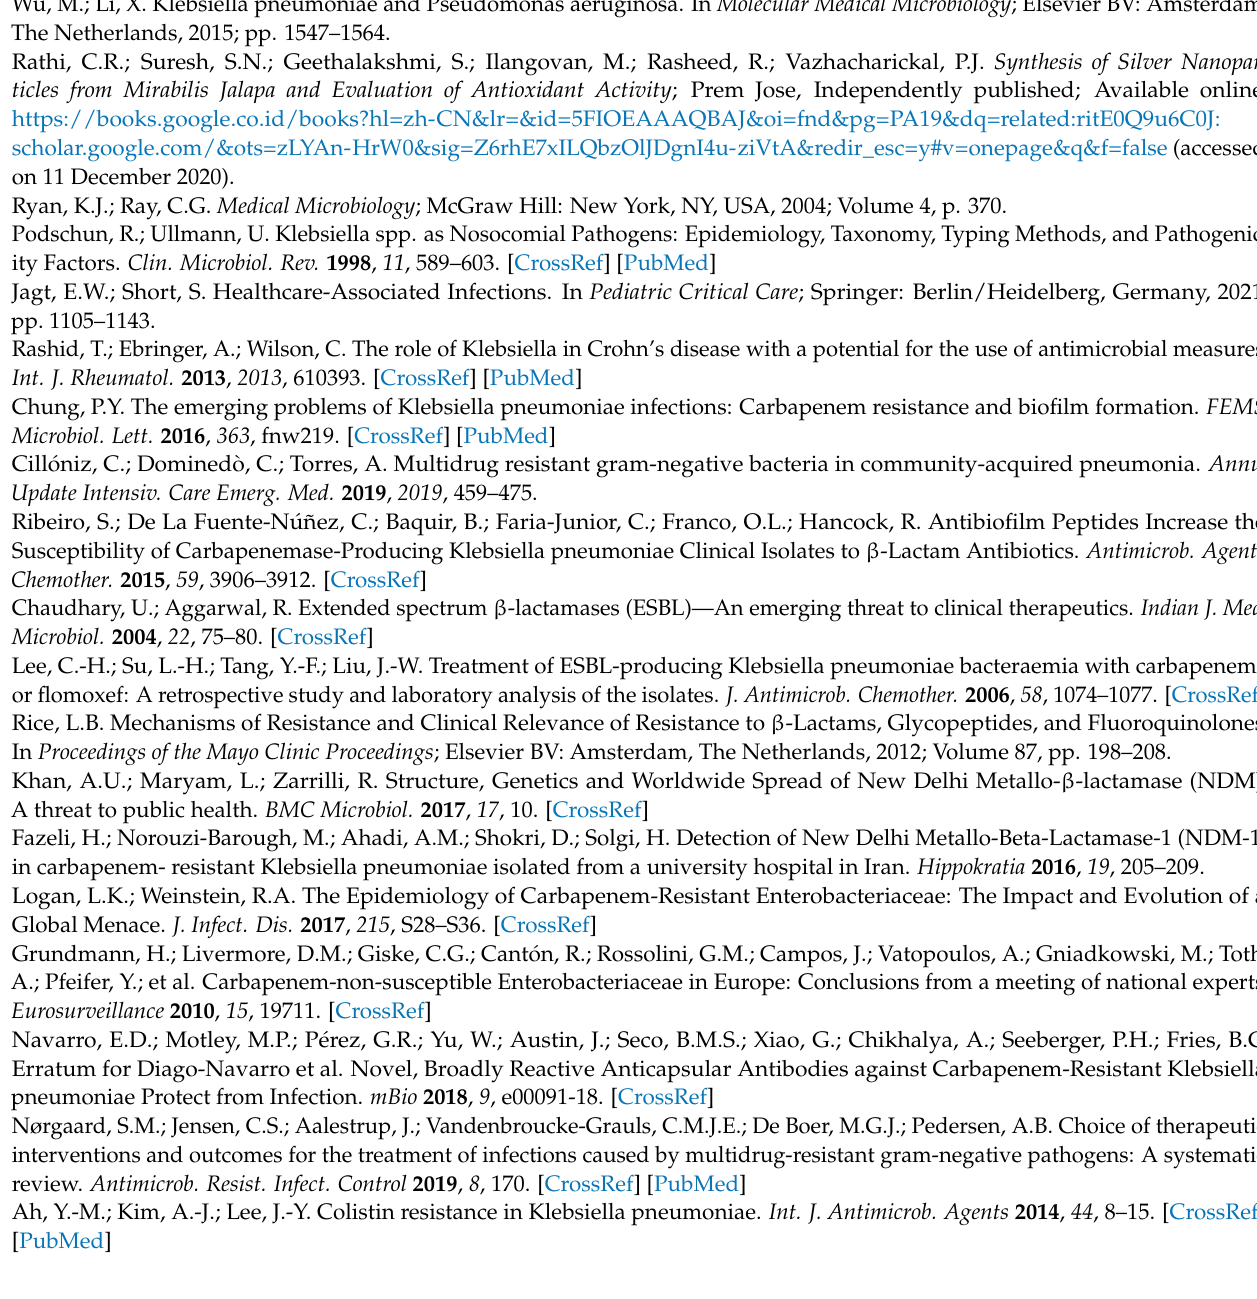
Table S3. Results of multi-epitope vaccine binding with TLR4; Table S4. Results of multi-epitope vaccine binding with MHCI; Table S5. Results of multi-epitope vaccine binding with